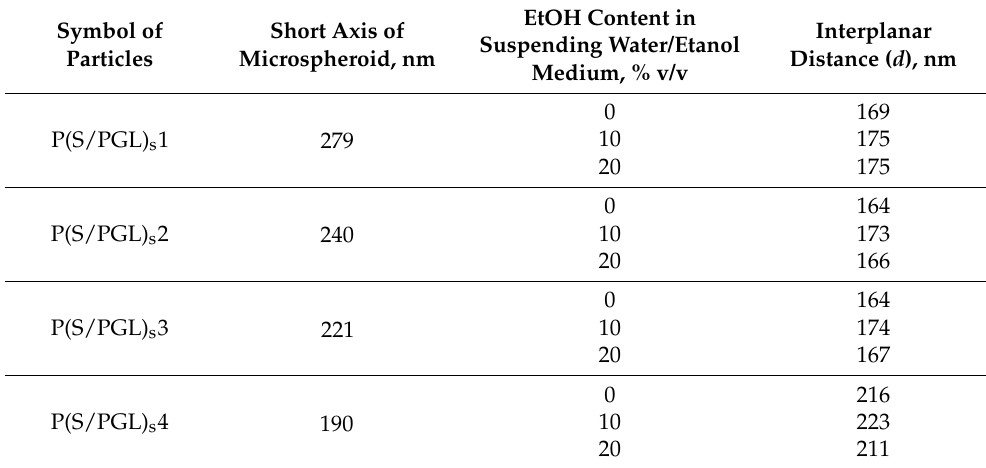
Table 3. Characteristics of spheroidal assemblies determined by angle-resolved UV spectroscopy.